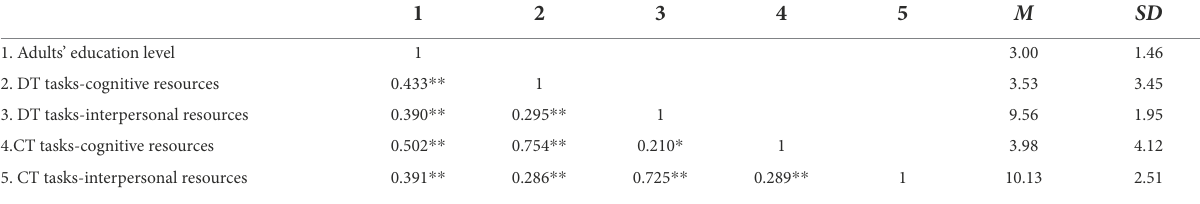
TABLE 4 Correlation analysis between adults’ education level and resources provided by